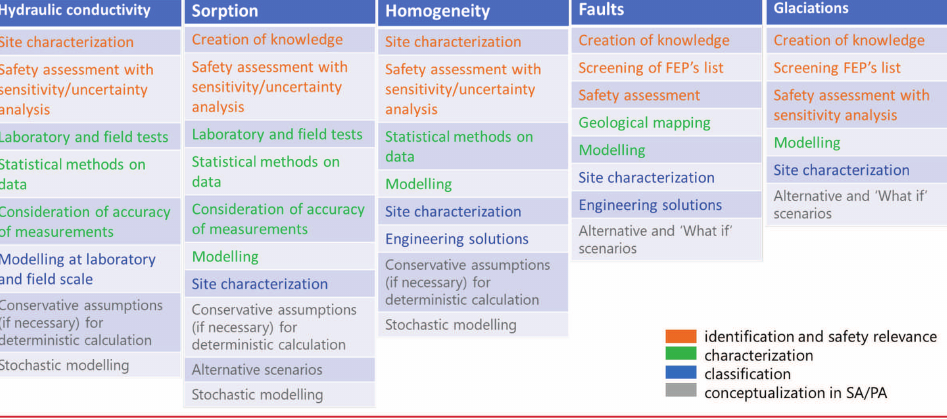
Fig. 9. Steps and options for uncertainties management at different stages of disposal programme